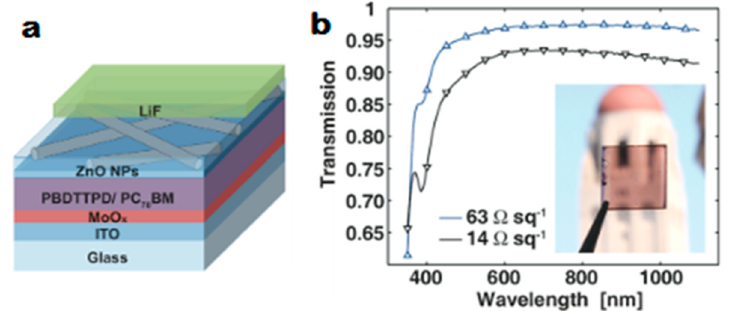
Figure 8. ( a ) Schematic of the semi-transparent OPV architecture. The LiF layer is partially removed in the schematic to better show the underlying layers, but covers the entire cell active area in actual devices ( b ) Transmission of Ag NW–ZnO NP composite electrodes with different sheet resistances. The reflection and absorption of the glass substrate has been subtracted. Inset is photograph of semi-transparent OPV